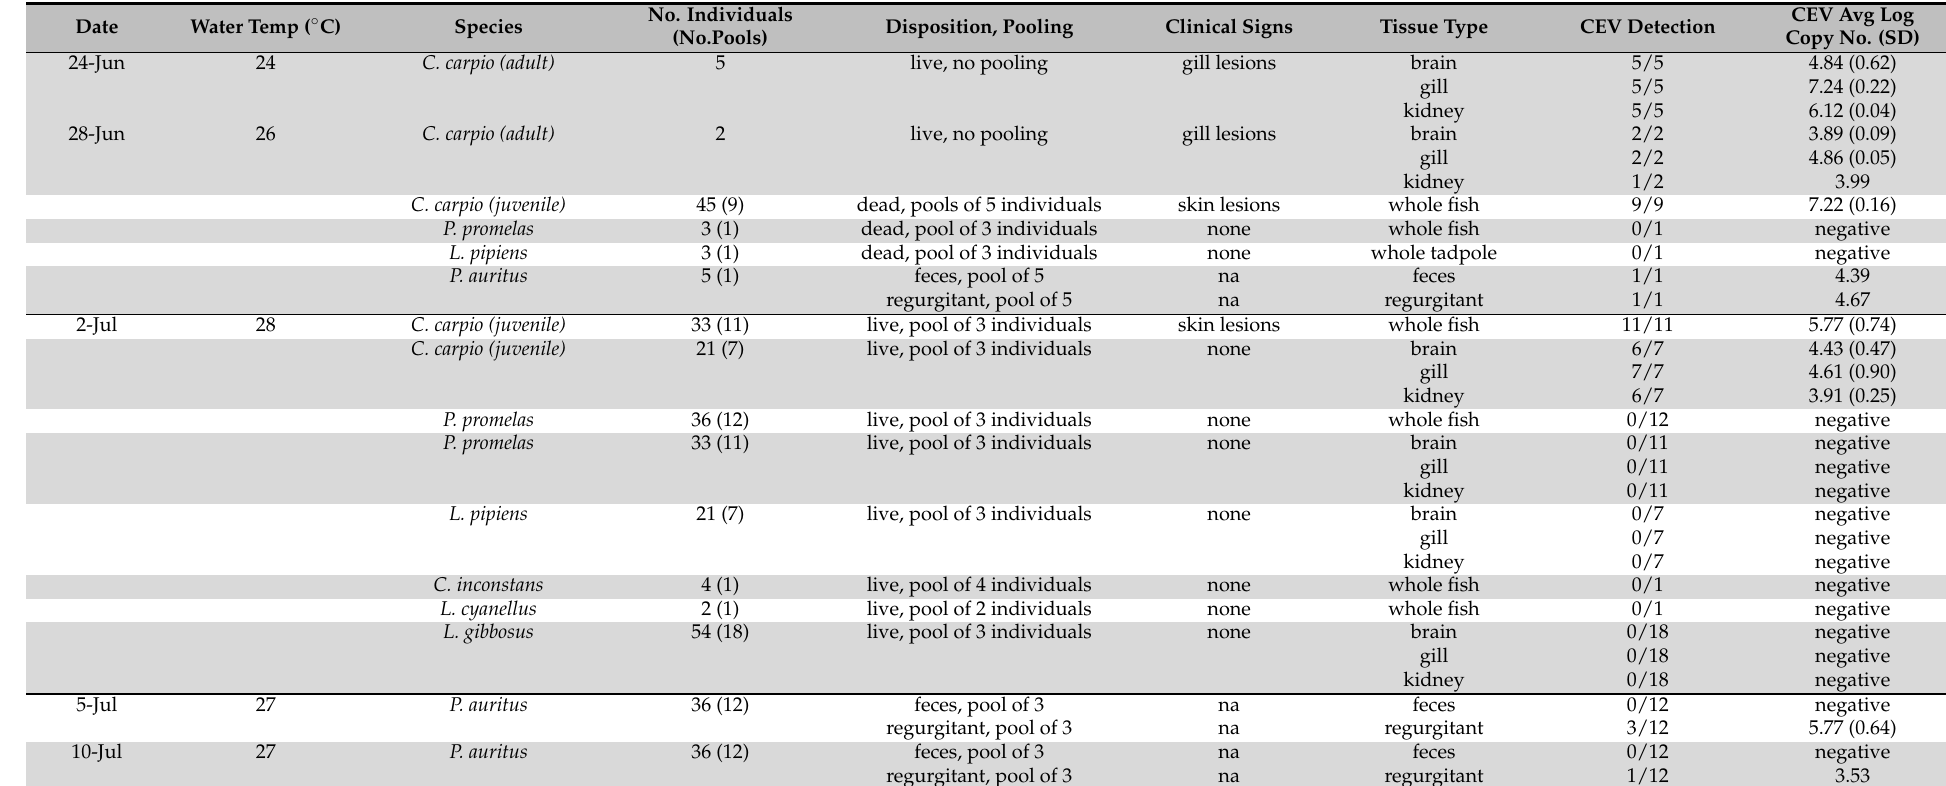
Table 1. Carp Edema Virus (CEV) positive survey samples from Lake